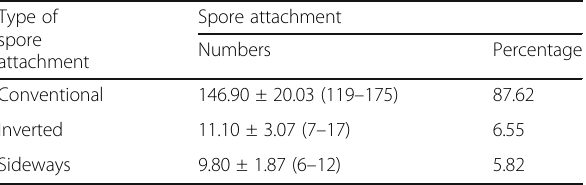
Table 1 Comparison of types of IISR-MiP endospore attachments (mean ± SE) with the cuticle of second-stage juveniles of Meloidogyne incognita ( n = 10) Type of spore